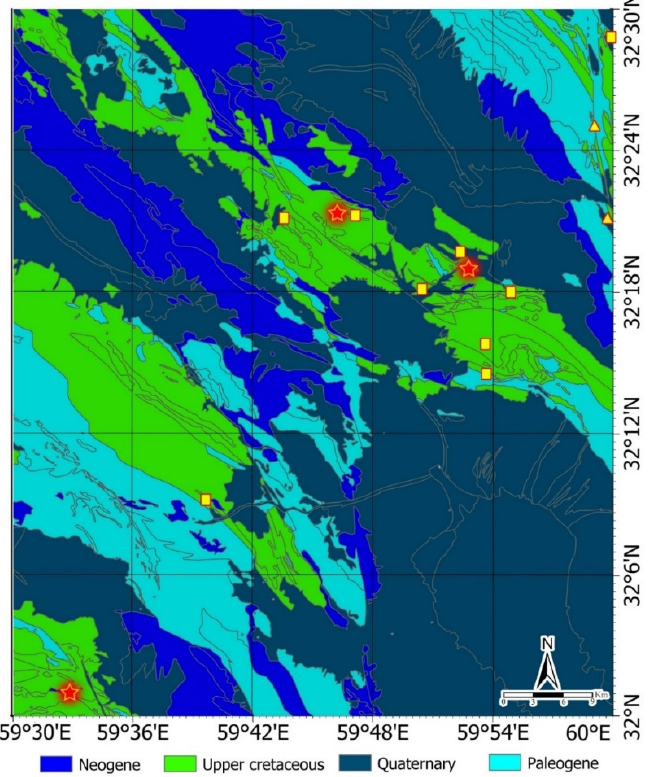
Figure 8. Geochronological map of the study area.